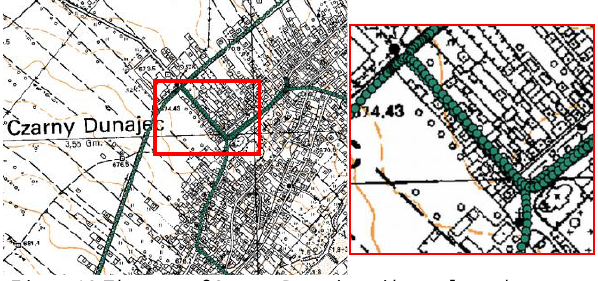
Figure 13 The map of Czarny Dunajec with overlapped routes of immersive video.